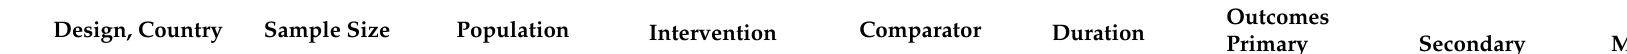
Table 1. Characteristics and methodology of the